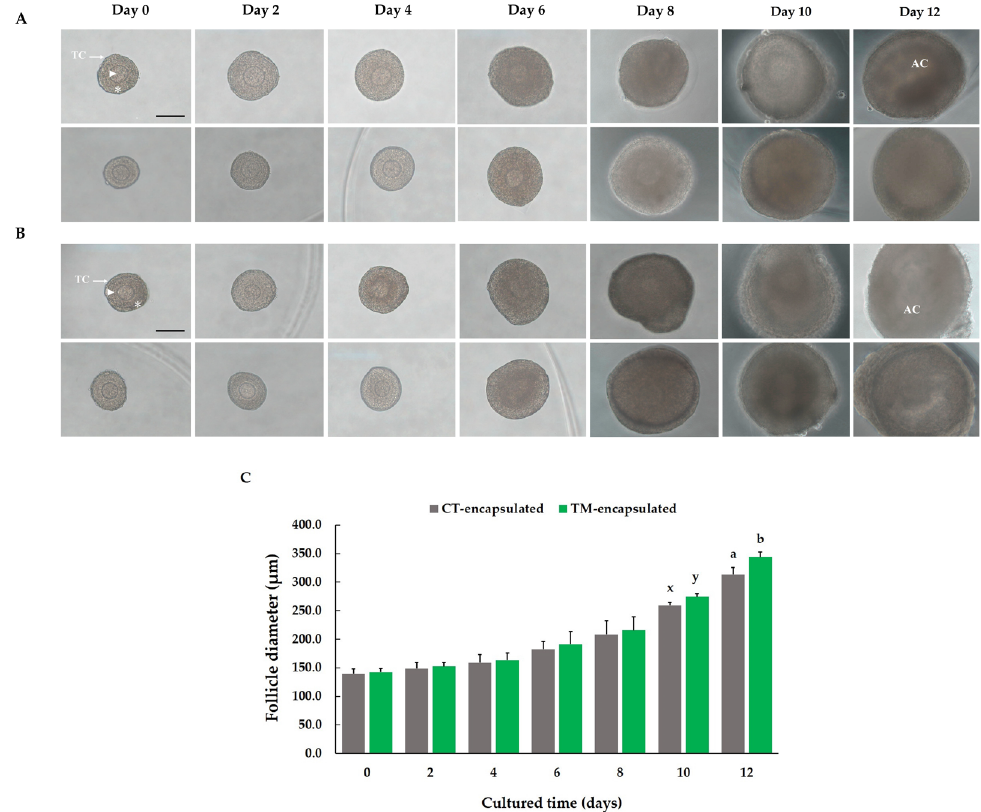
Figure 2. Morphology and growth of in vitro 3-dimensional culture of preantral follicles isolated from ovaries of 14–16-day-old female mice. Representative normal images of ( A ) CT-encapsulated follicles and ( B ) TM-encapsulated follicles on days 0, 2, 4, 6, 8, 10, and 12 of culture in a 3D alginate matrix. Scale bar: 100 µm. ( C ) Diameters of follicles grown in the two culture media. Within each day of cultured time (days), values with different superscript letters (a,b) indicate significant differences at p < 0.05, while values with different superscripts (x,y) tend to differences at 0.05 < p ≤ 0.10 in diameter between the two groups of follicles. Comparison between groups was performed using Student’s t -test. n = 50 follicles for ten replications. Arrowhead: oocyte; asterisk: GCs (granulosa cells); TC: thecal cells; AC: antrum